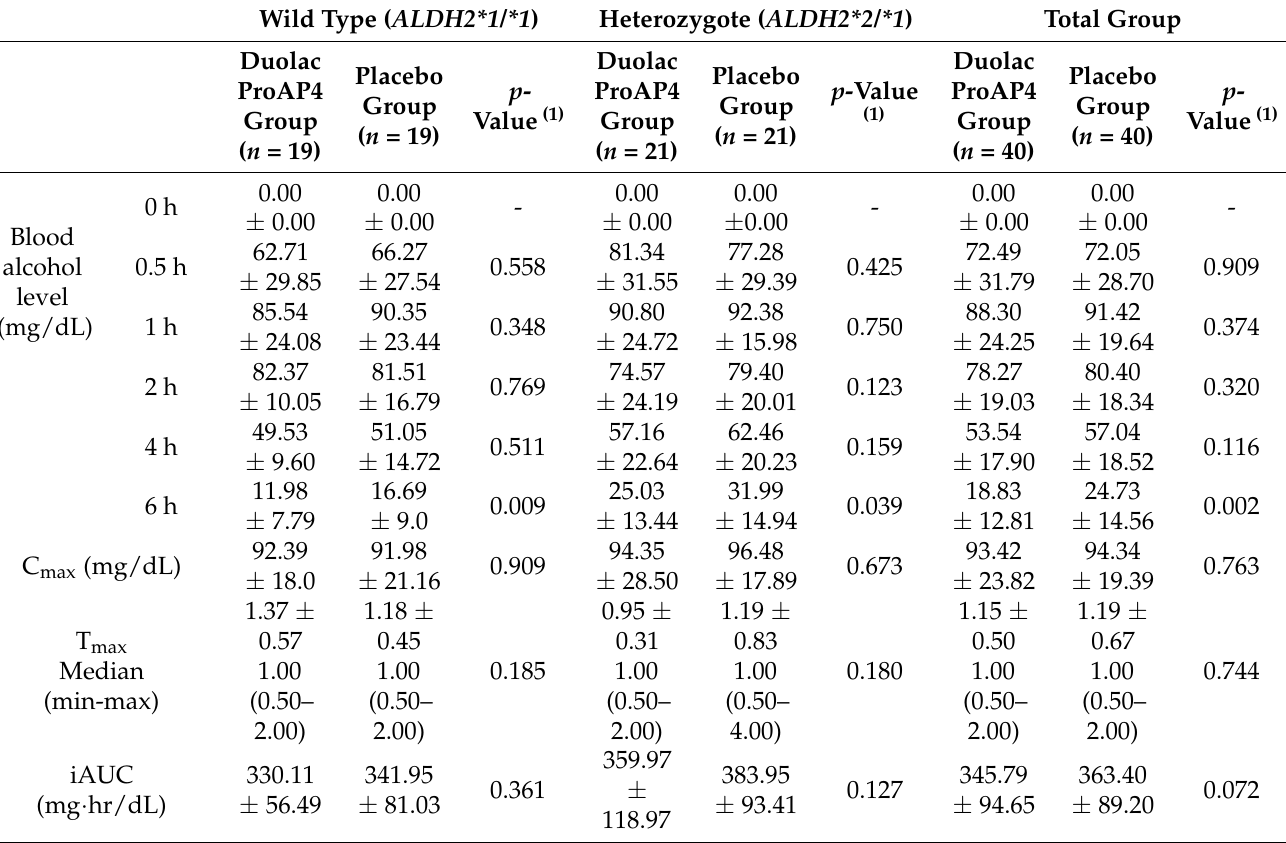
Table 3. Variation in blood alcohol concentration flowing alcohol challenge test after 15 days of